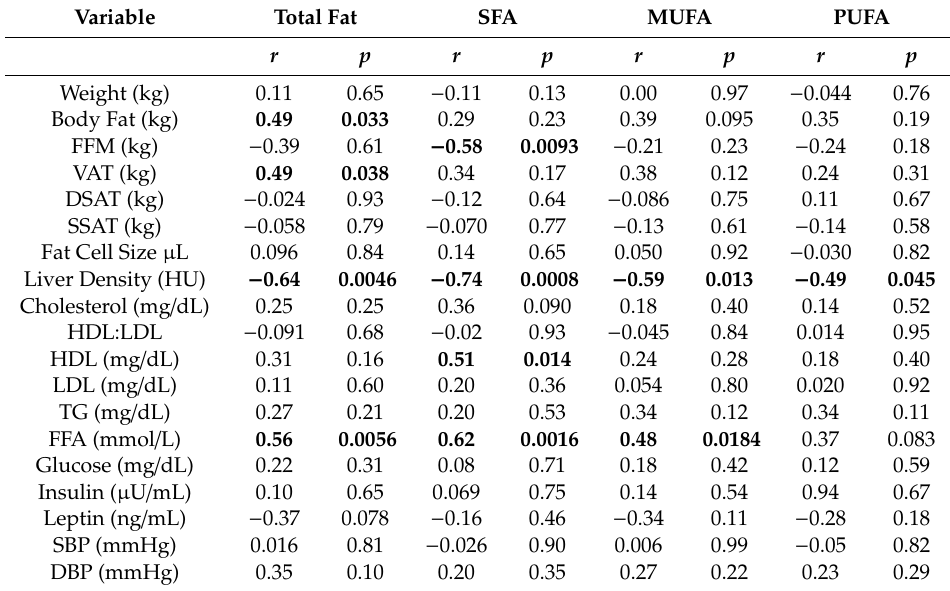
Table 3. Linear correlation of total dietary fat, saturated fat, monounsaturated fat (MUFA), and polyunsaturated fat (PUFA) with changes in metabolic variables during overeating.